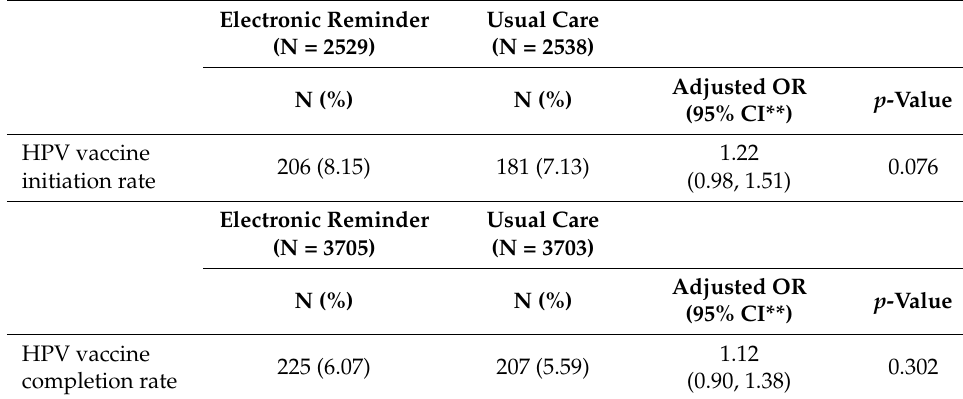
Table 4. Subgroup vaccination